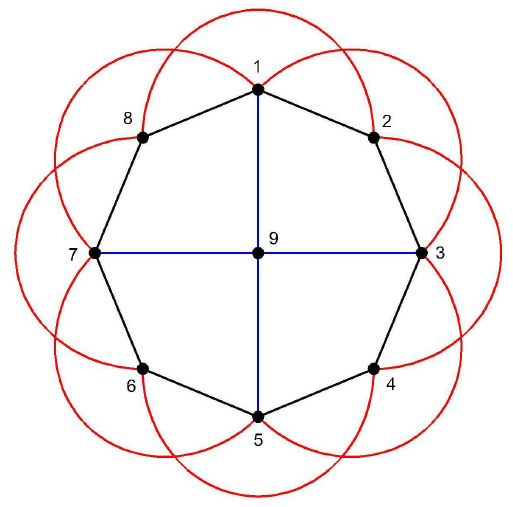
Figure 5. Graph of I ( AWG 9 )